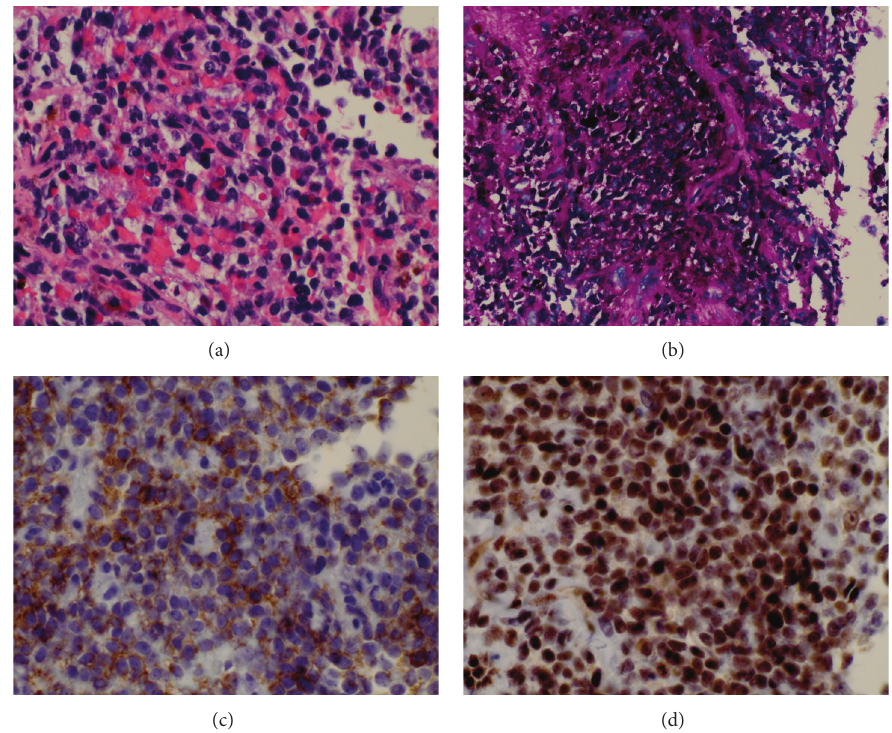
Figure 2: Histopathological investigation of the biopsied mass included (a) H&E staining that revealed round hyperchromatic nuclei with little cytoplasm and numerous mitoses. (b) Positive PAS staining of the tumor cells shows these cells to be glycogen rich. There is also positive staining for (c) CD-99 and (d)